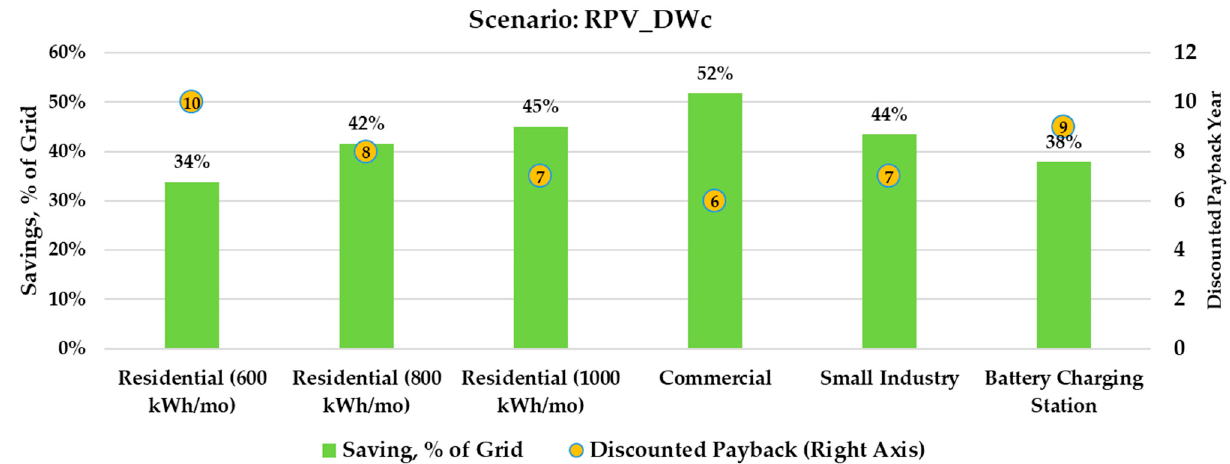
Figure 7. Estimated savings and discounted payback periods for low‑voltage consumers. Scenario: rooftop RSPP located within the distribution network of the consumer. Table 9. Saving and discounted payback period overview for all scenarios.